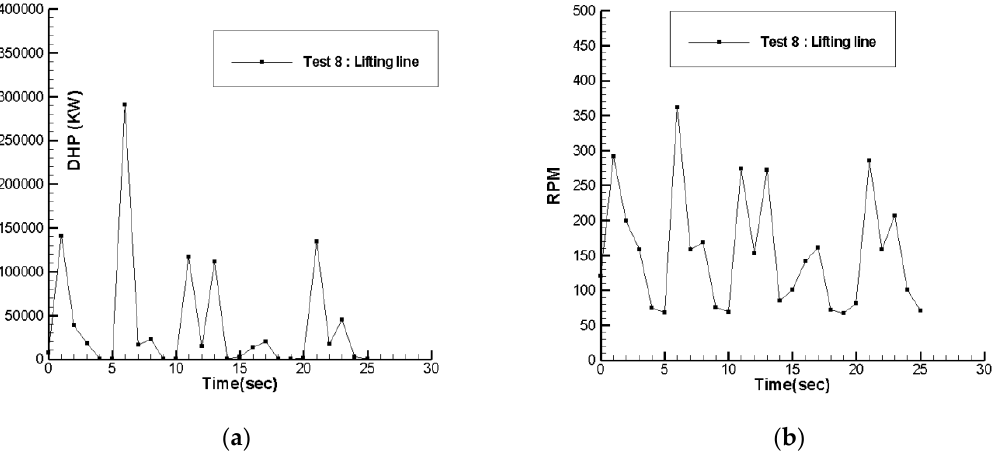
Figure 35. Time history of the required DHP ( a ) and RPM ( b ), numerical experiment #8.